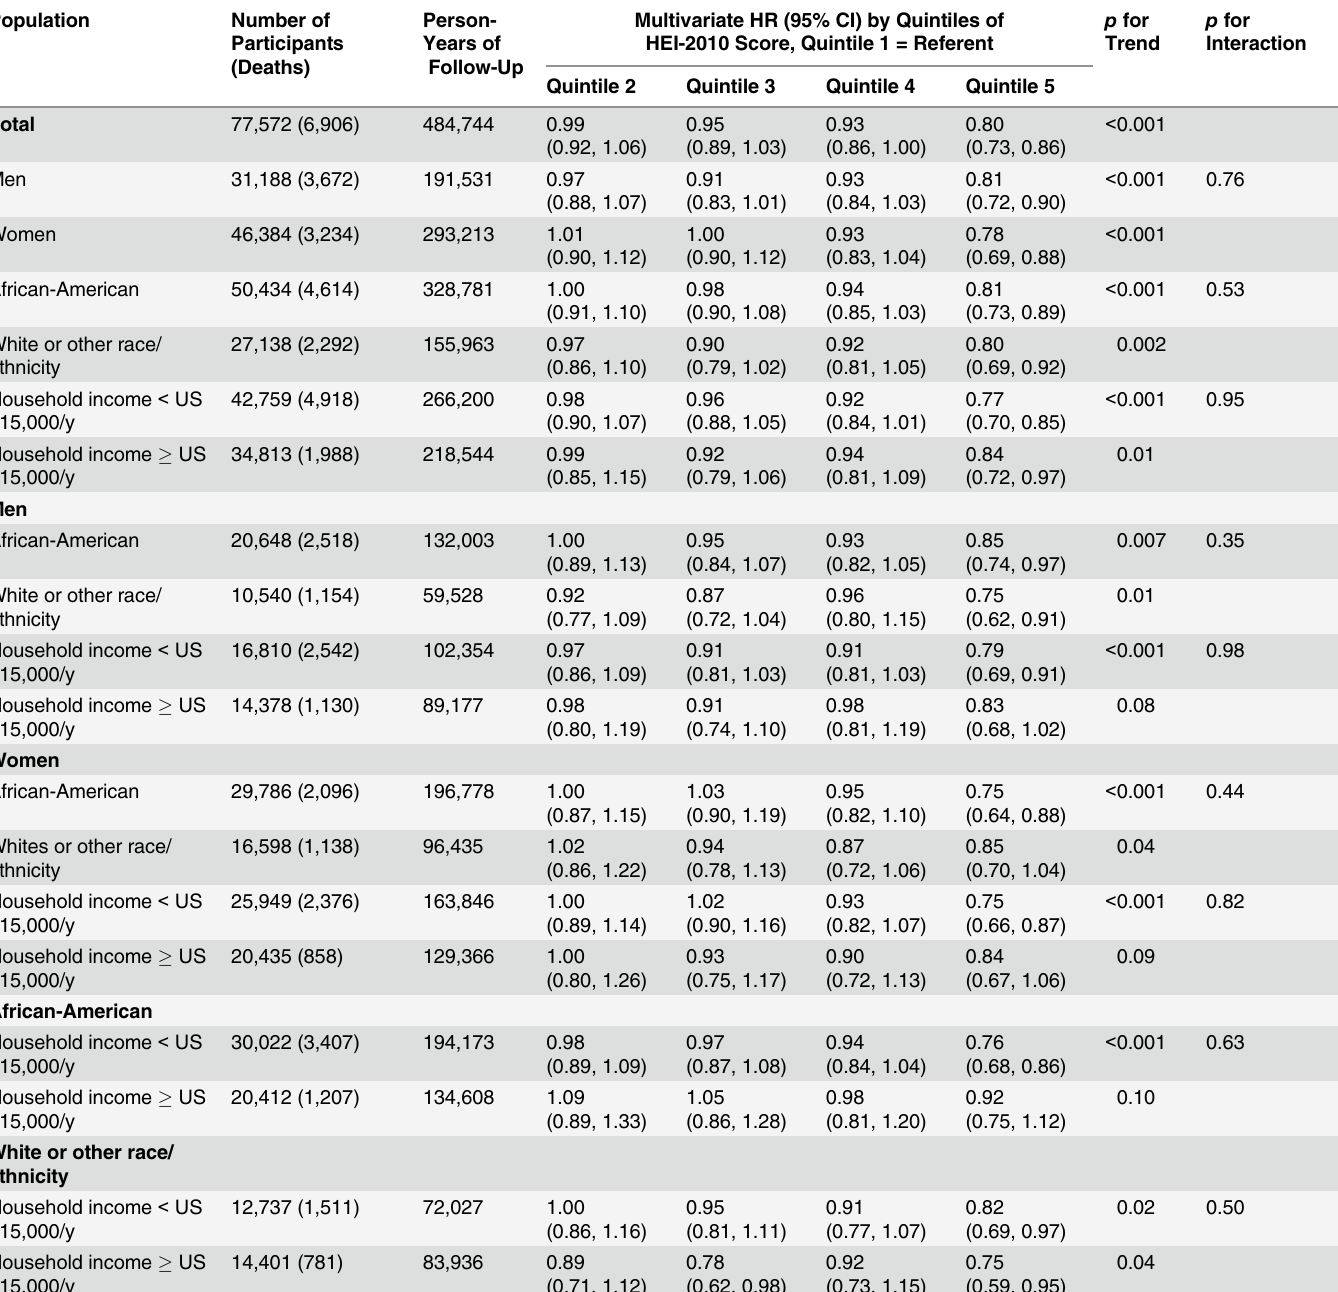
Table 2. Association of HEI-2010 score and total disease mortality by sex, race, and income in the Southern Community Cohort Study, 2002 –